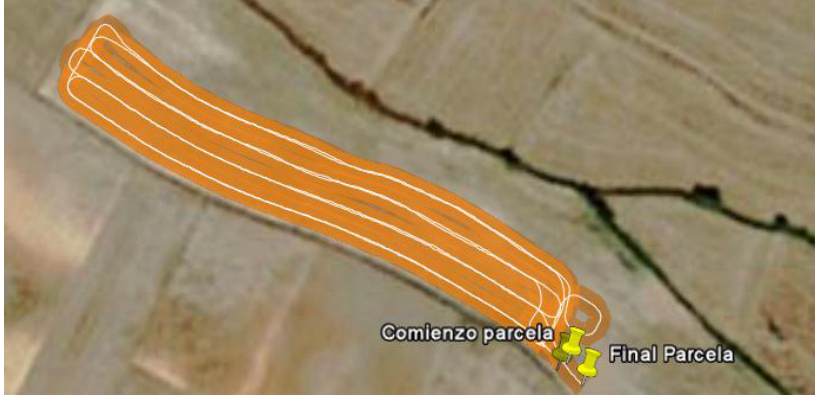
Figure 6. Visualization with Google Earth of the trajectories and treated zones in the real